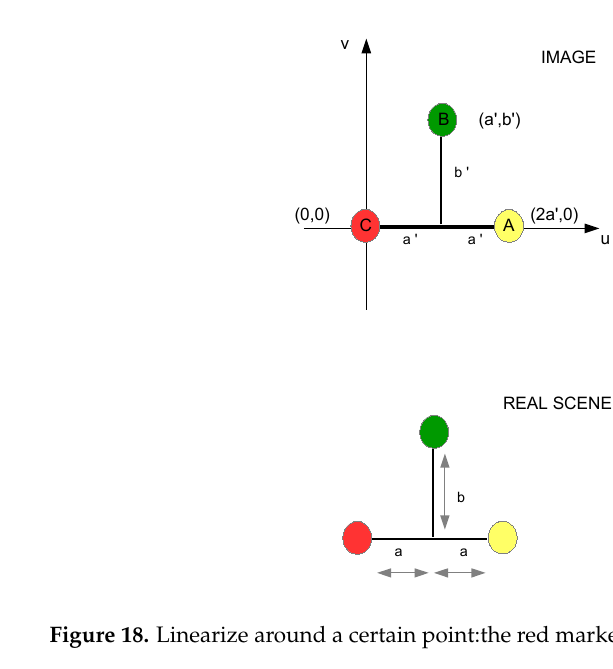
Figure 18. Linearize around a certain point:the red marker was centered at zero.